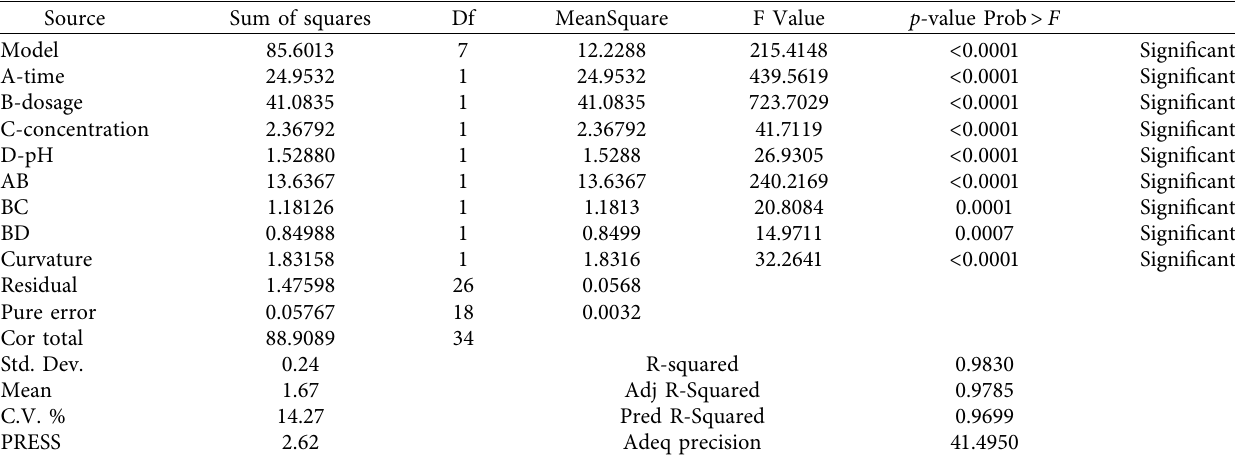
Table 2: Anova (analysis of variance) for 2-level factorial of BRR adsorption capacity.